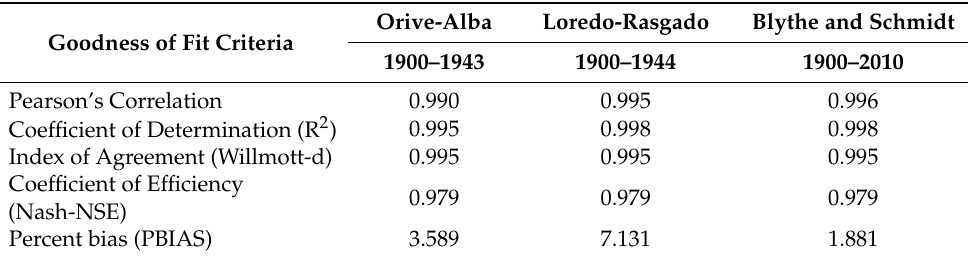
Table 1. Statistical comparison of the estimated natural flows and the available studies of Orive de Alba [38], Loredo-Rasgado [37], and Blythe and Schmidt [33]. Orive-Alba Loredo-Rasgado Blythe and Schmidt Goodness of Fit Criteria